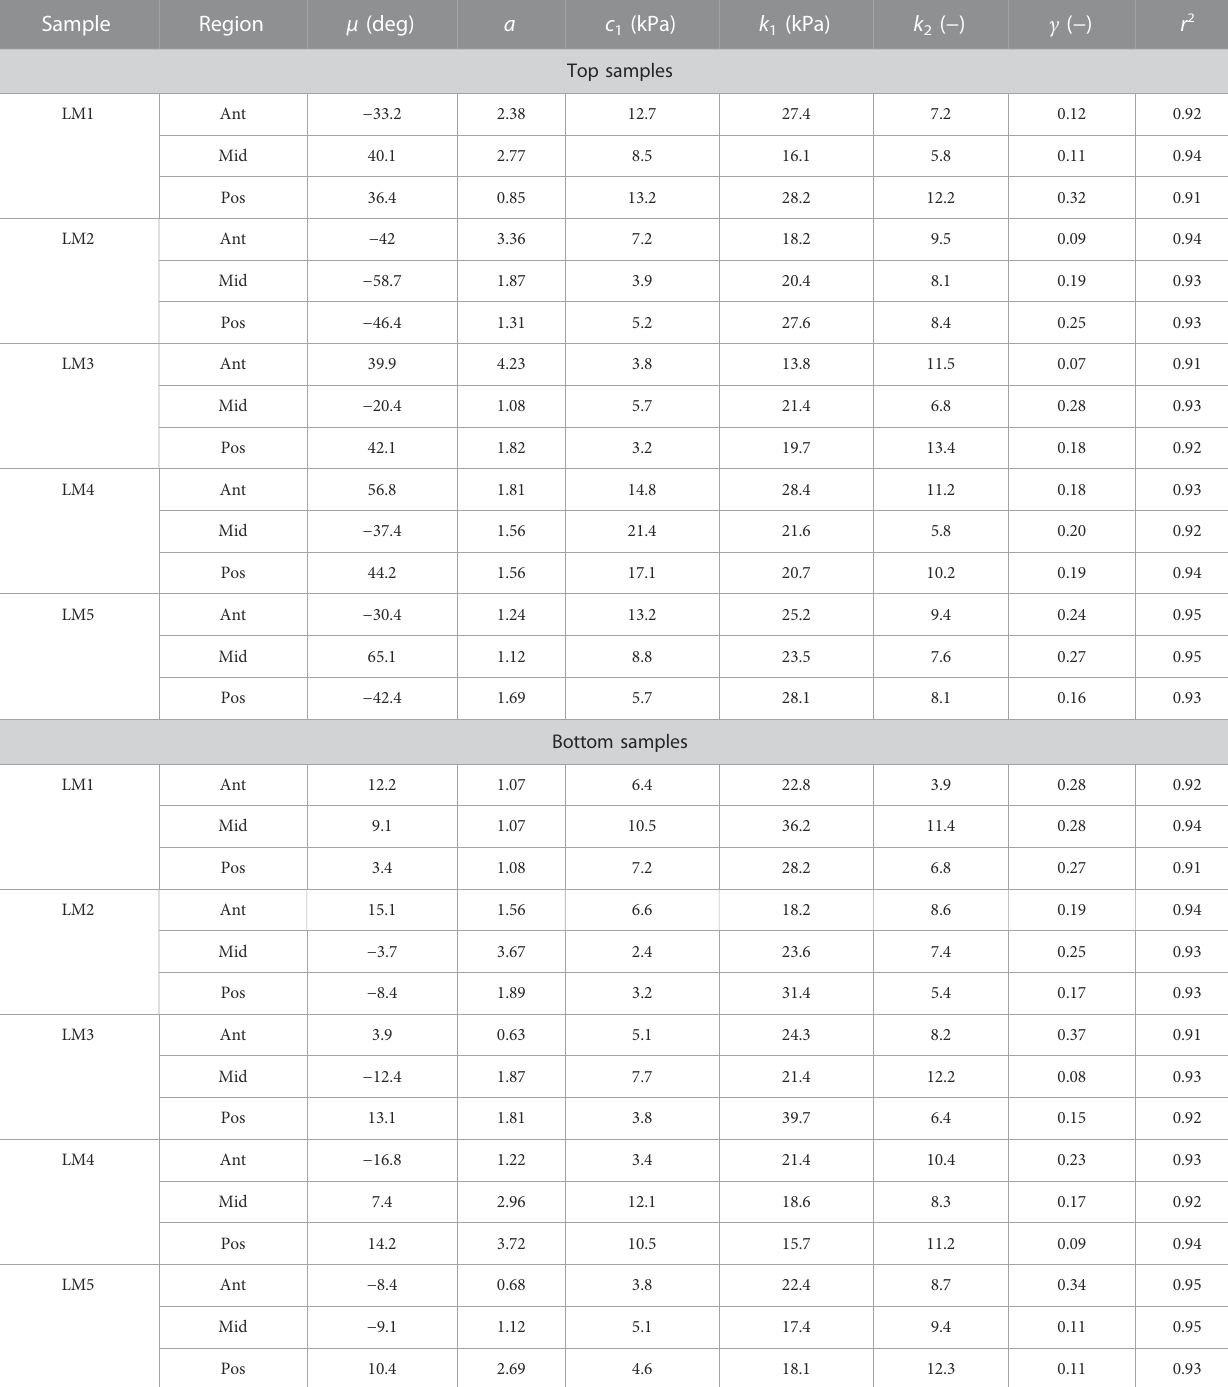
TABLE 1 Collagen morphology and tissue material parameters for top and bottom samples from lateral menisci. LM denotes lateral meniscus. Sample Region μ